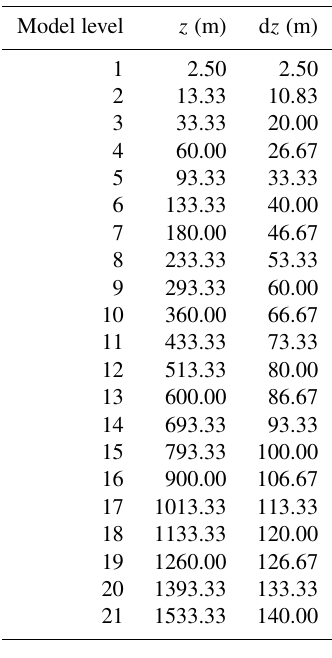
Table 1. The model vertical grid spacing (d z ) of the inner 1km nest as a function of height ( z ) for the boundary